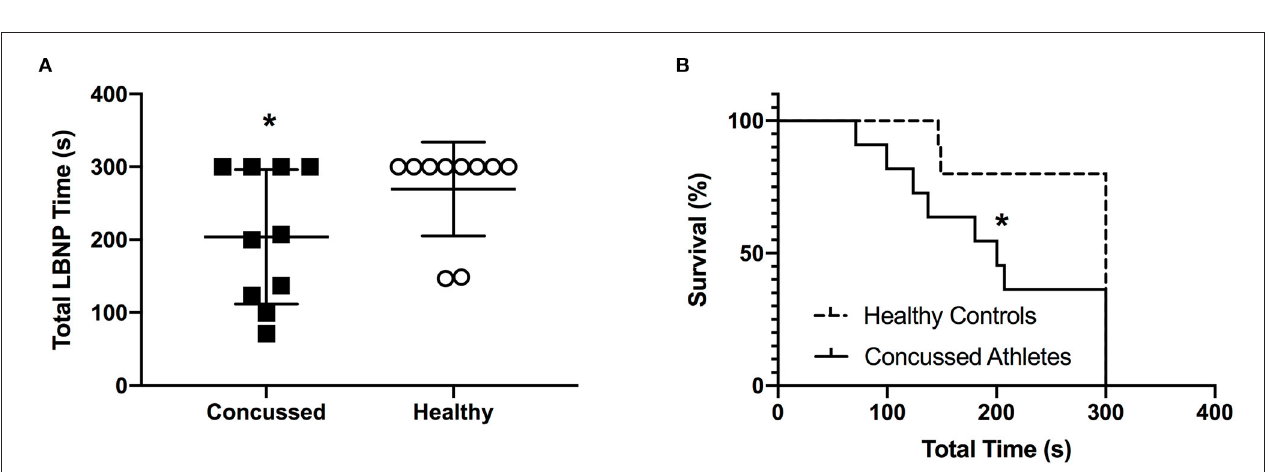
FIGURE 4 | Total LBNP time (A) and Kaplan-Meier survival curve (B) for Concussed Athletes vs. Healthy Controls. Values are mean ± SD. *Different from Healthy Controls ( P ≤ 0.05).